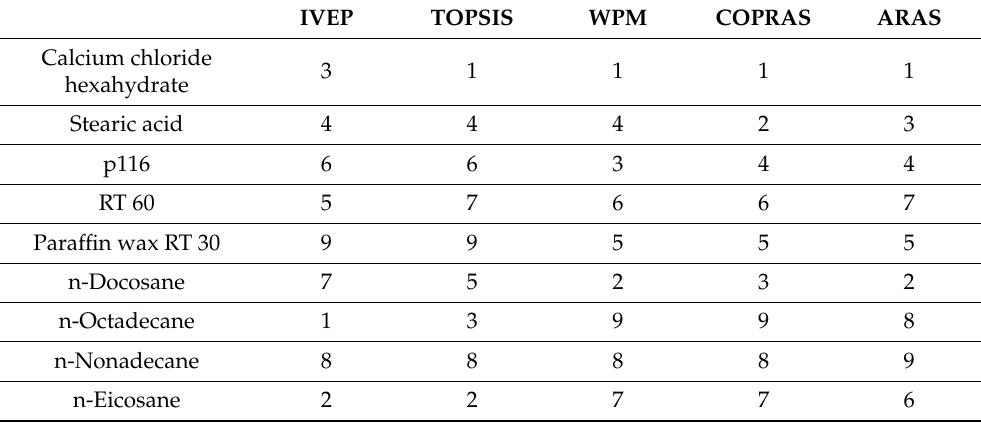
Figure 4. The difference between the rankings of materials generated by different MCDM methods. Table 4. The ranks of materials generated by different MCDM